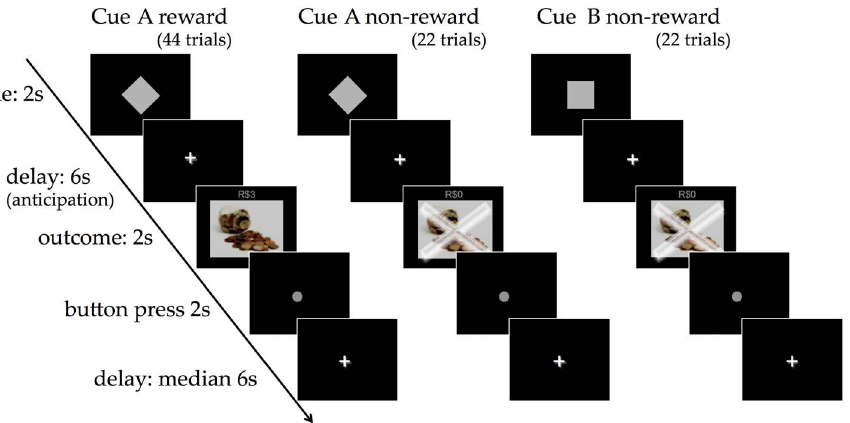
Figure 1. Classical conditioning fMRI paradigm. One of two neutral stimuli (Cue A or Cue B) was followed by an outcome stimulus (reward or non-reward) after a 6-second delay. Cue A was followed by the delivery of the reward 66% of the time and non-reward 33% of the time. Cue B was always followed by non-reward. Participants were told they would receive the equivalent of R $ 3 for each reward outcome. The length of the inter-trial delay was